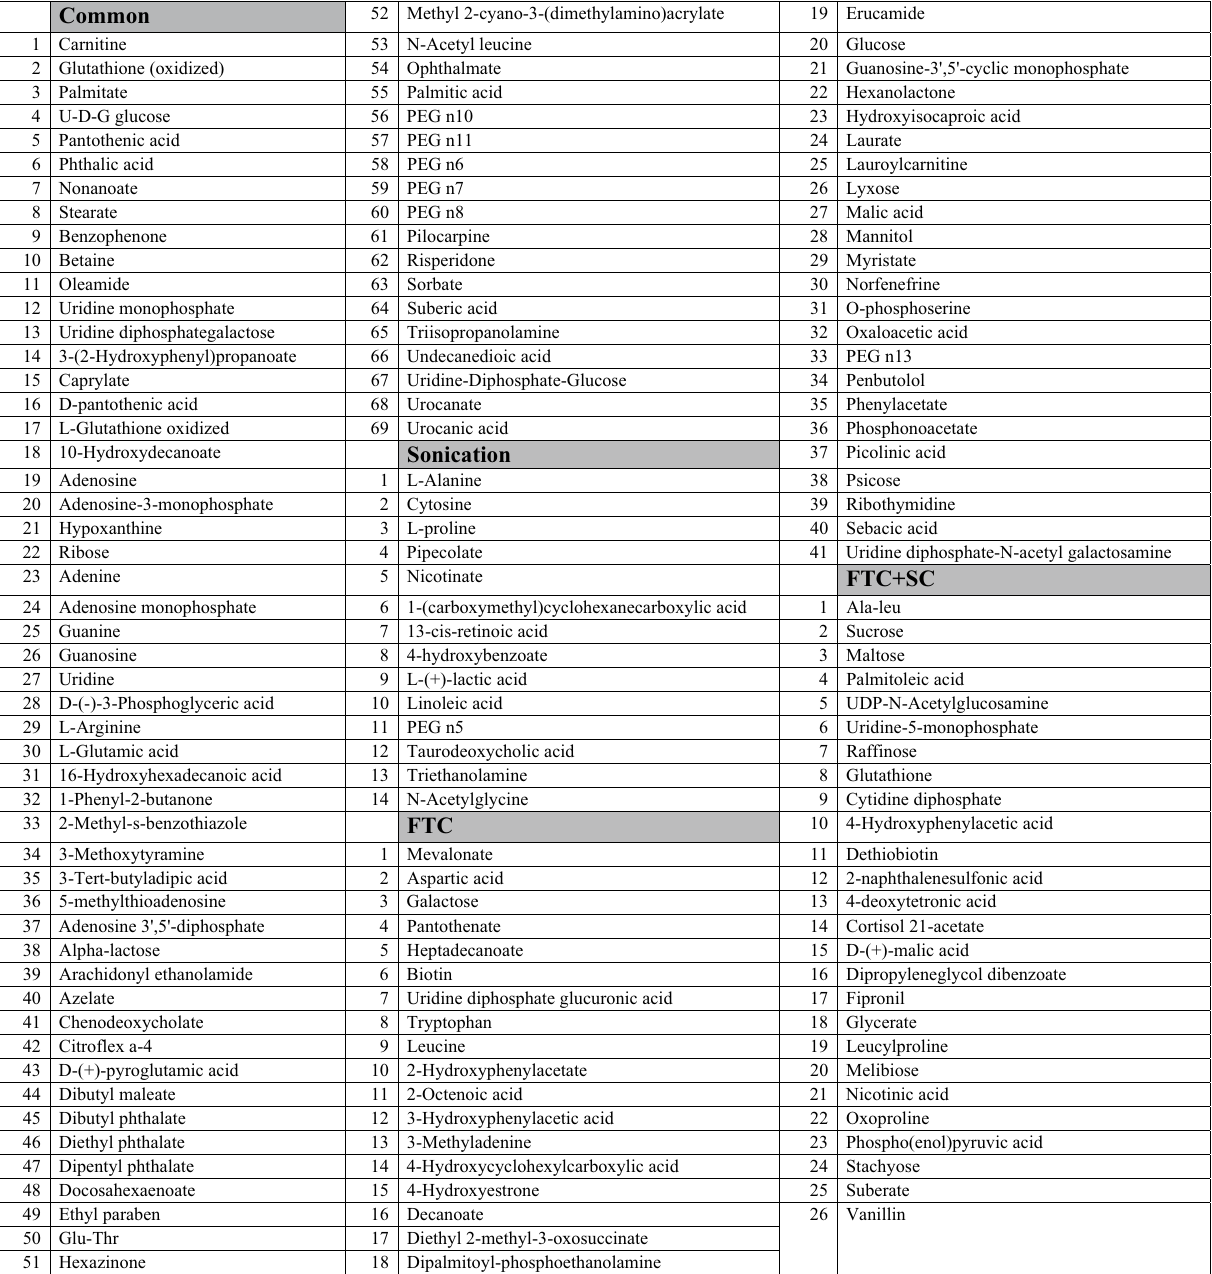
Table 1. List of extraction protocol specific unique metabolites identified using SC, FTC and FTC + SC along with common metabolites (identified by all